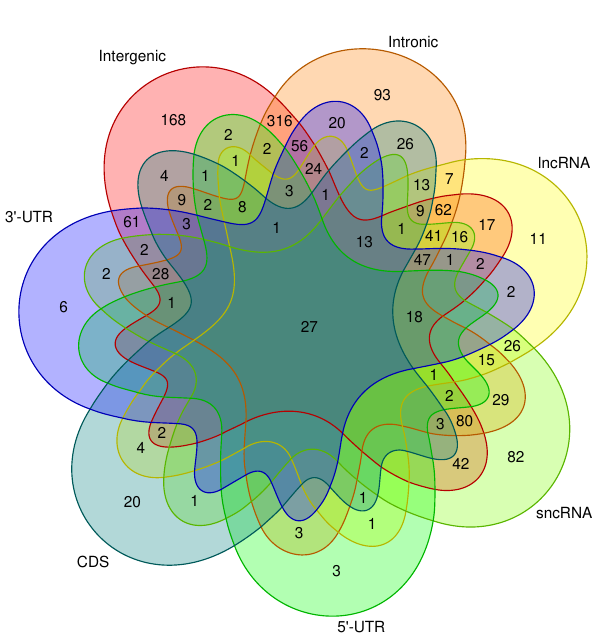
Figure 5. Total number of unique, non-repeat-associated covariance models (CMs) that hit in different genomic intervals. Only CMs with more than two hits were taken into account. Out of 1444 CMs with at least two hits, we observed that only 27 are found among all genomic intervals. Three-hundred-sixteen CMs hit intergenic and intronic regions, while 168 and 93 CMs hit only intergenic or intronic regions, respectively. Eighty-two models exclusively hit short noncoding RNAs (sncRNAs), and a combined 151 models hit sncRNAs and intergenic or intronic or both. Out of all CMs, only 3, 20, and 6 are found exclusively in the 5’-UTR, CDS, and 3’-UTR, respectively. In addition, we found that many CMs give hits in a multitude of different genomic contexts. lncRNA: long non-coding